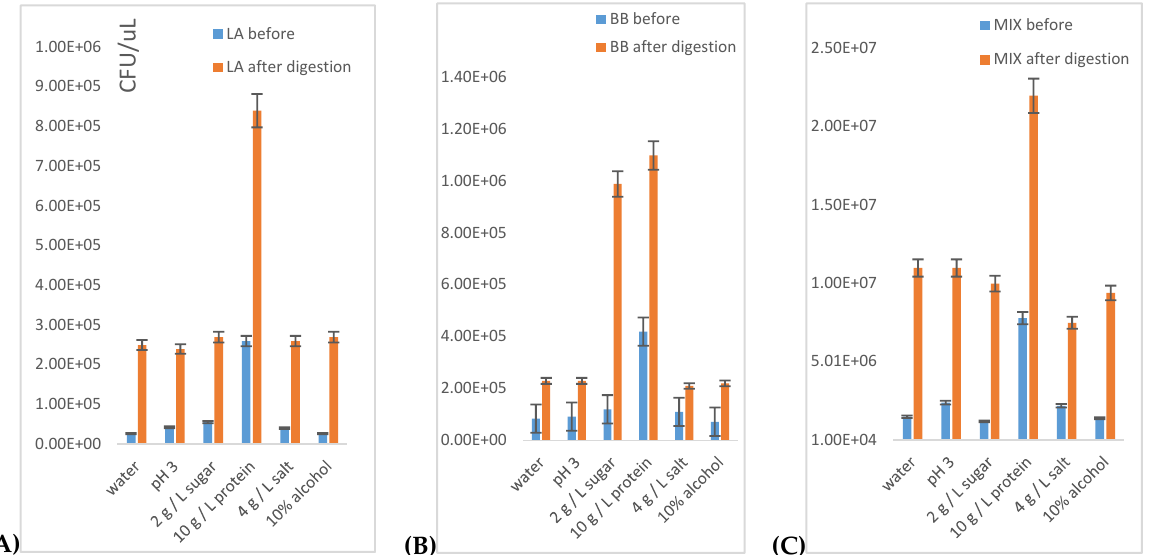
Figure 2. The influence of model foods and the type of probiotic on the number of viable cells after model digestion: ( A ) Lactobacillus acidophilus , ( B ) Bifidobacterium breve and ( C ) probiotic mixture.